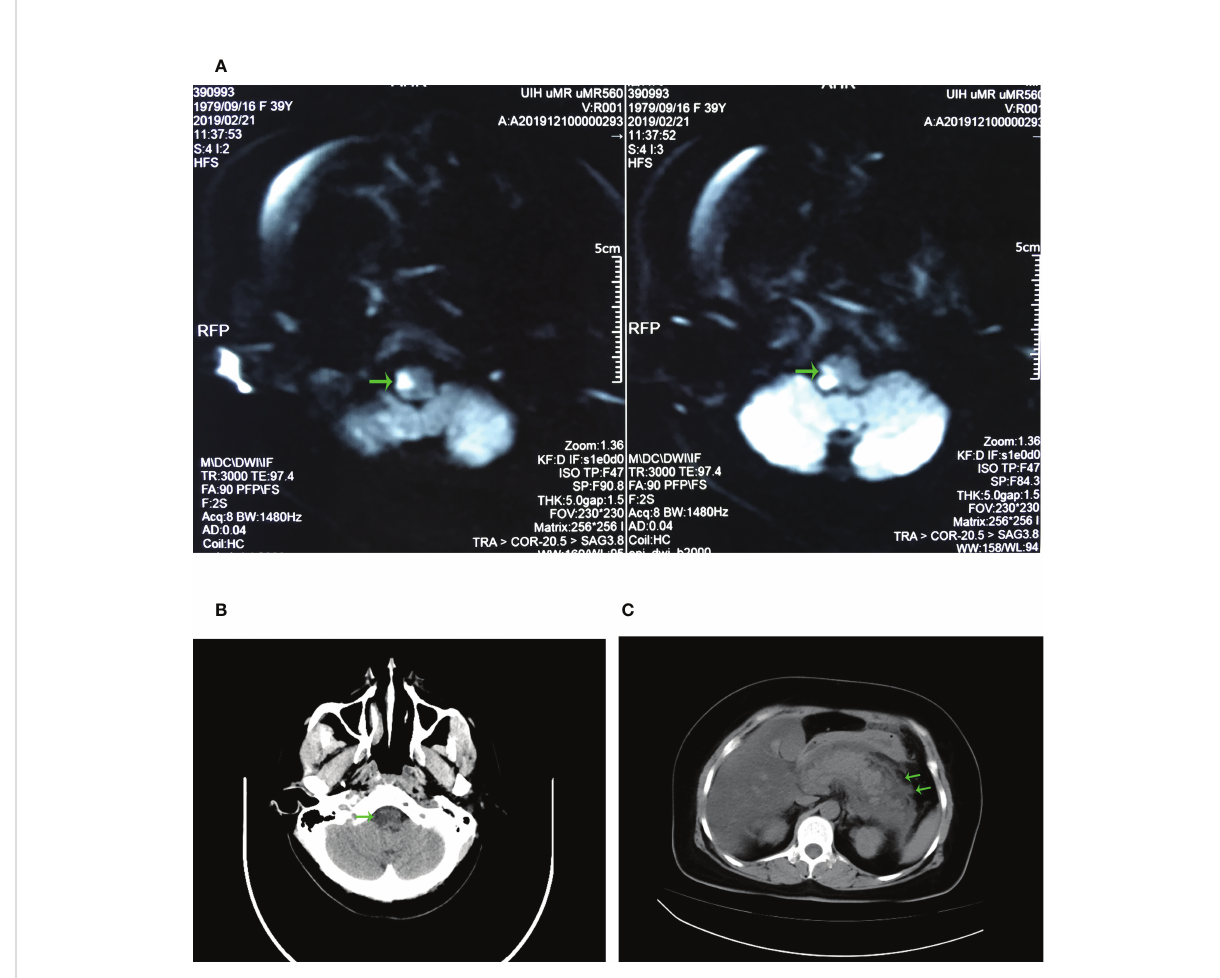
FIGURE 1 Radiology results. (A) Patient ’ s cranial DWI imaging. The green arrow marks the abnormal signal on the right side of the patient ’ s medulla oblongata, which is considered as acute cerebral infarction. (B) CT imaging of the patient ’ s head. The green arrow marks a small hypodense lesion on the right side of the medulla oblongata, suggesting the possibility of infarction on the right side of the medulla oblongata. (C) CT imaging of the patient ’ s abdomen. The green arrow marks the swelling and exudation of the pancreas, indicating acute